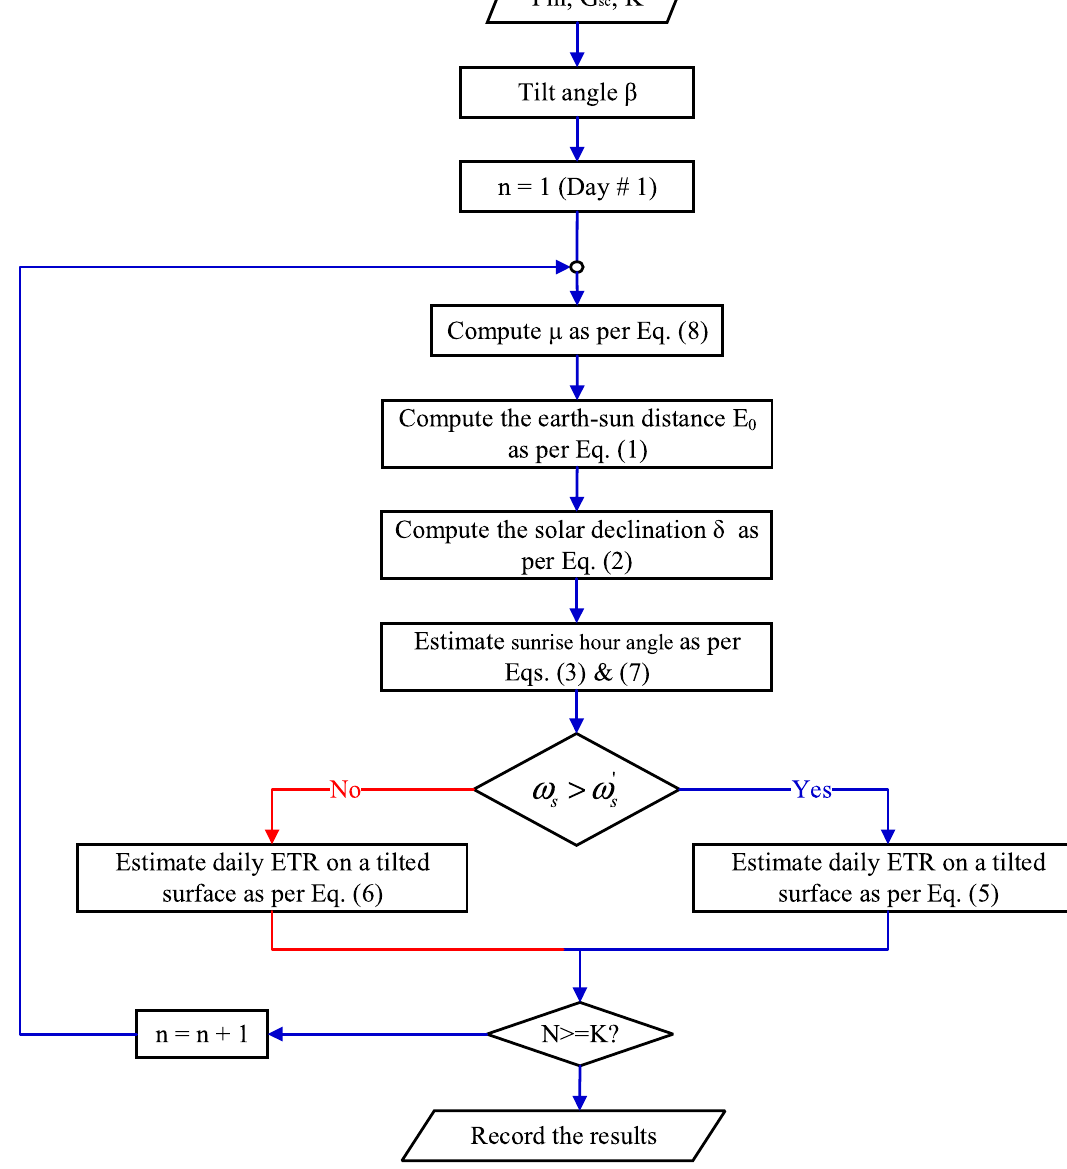
Figure 4. Computation procedure to calculate the SR for certain tilts angle